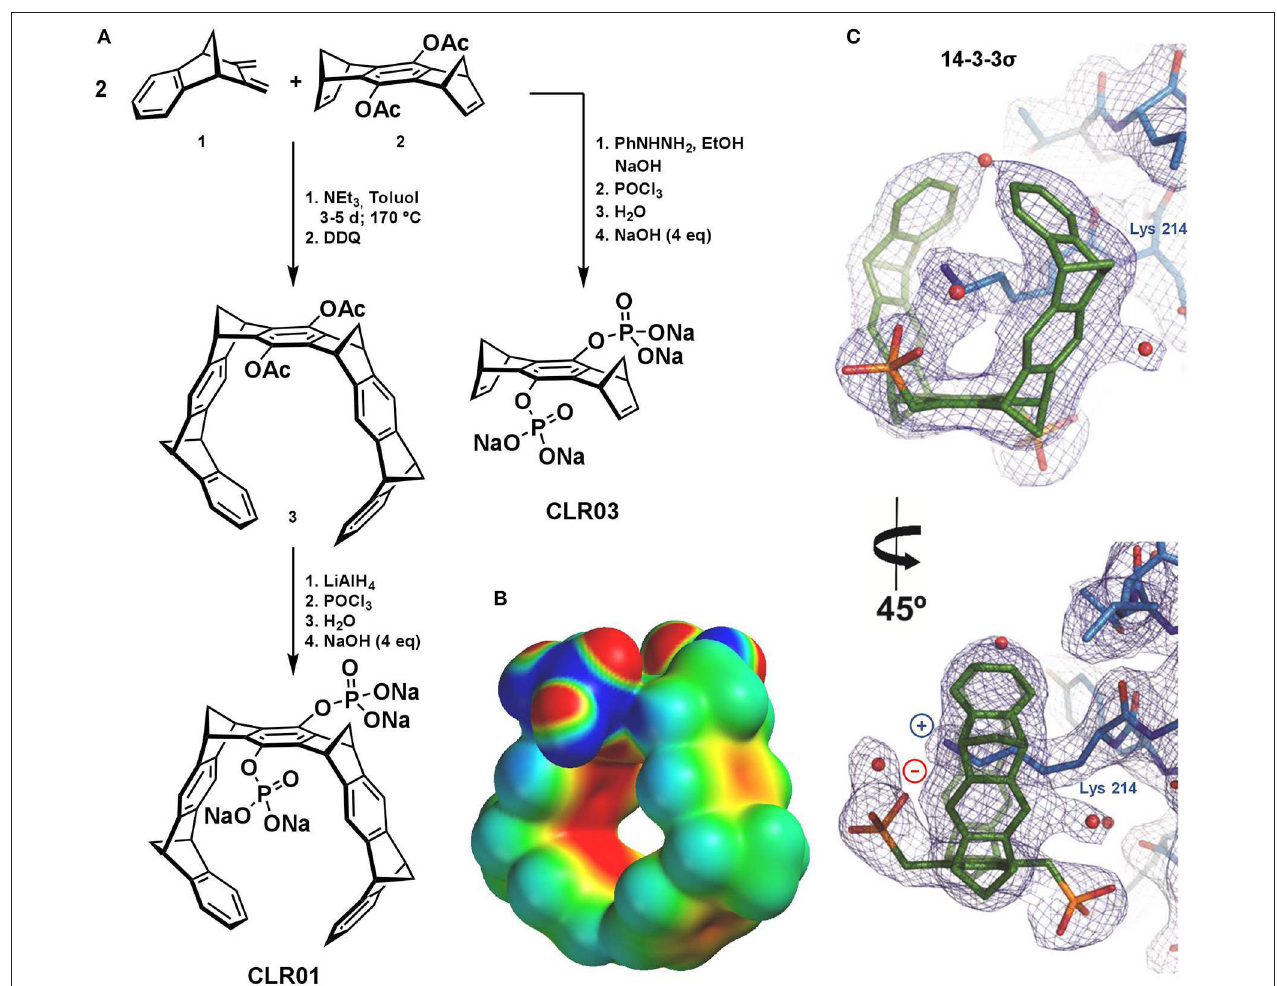
FIGURE 1 | (A) Synthesis of the molecular tweezer CLR01 (Talbiersky et al., 2008) and negative control CLR03 (Kirsch et al., 2009). (B) Electrostatic Surface Potential of CLR01 calculated by PM3 implemented in SPARTAN 04 (Wavefunction Inc.) Color code spans from − 25 kcal/mol (red) to + 25 kcal/mol (blue), taken from ( Heid et al., 2018 , Figure 5). (C) 2Fo–Fc electron density (contoured at 1s) for the molecular tweezers bound to 14-3-3 σ (Bier et al., 2013, Figure